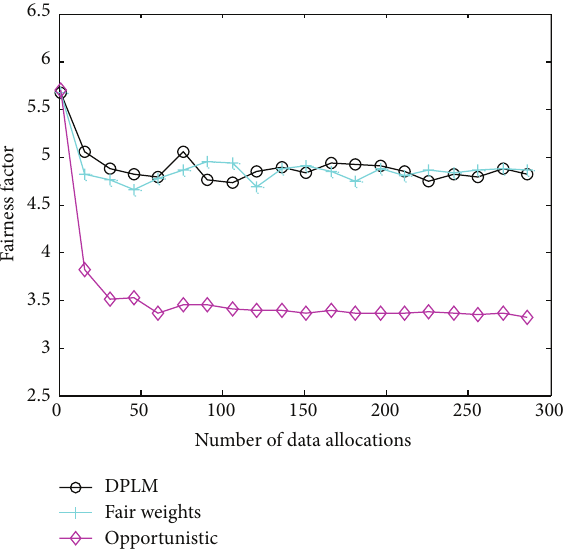
Figure 7: Fairness factor achieved from pure opportunistic, DPLM, and fair weights scheme.